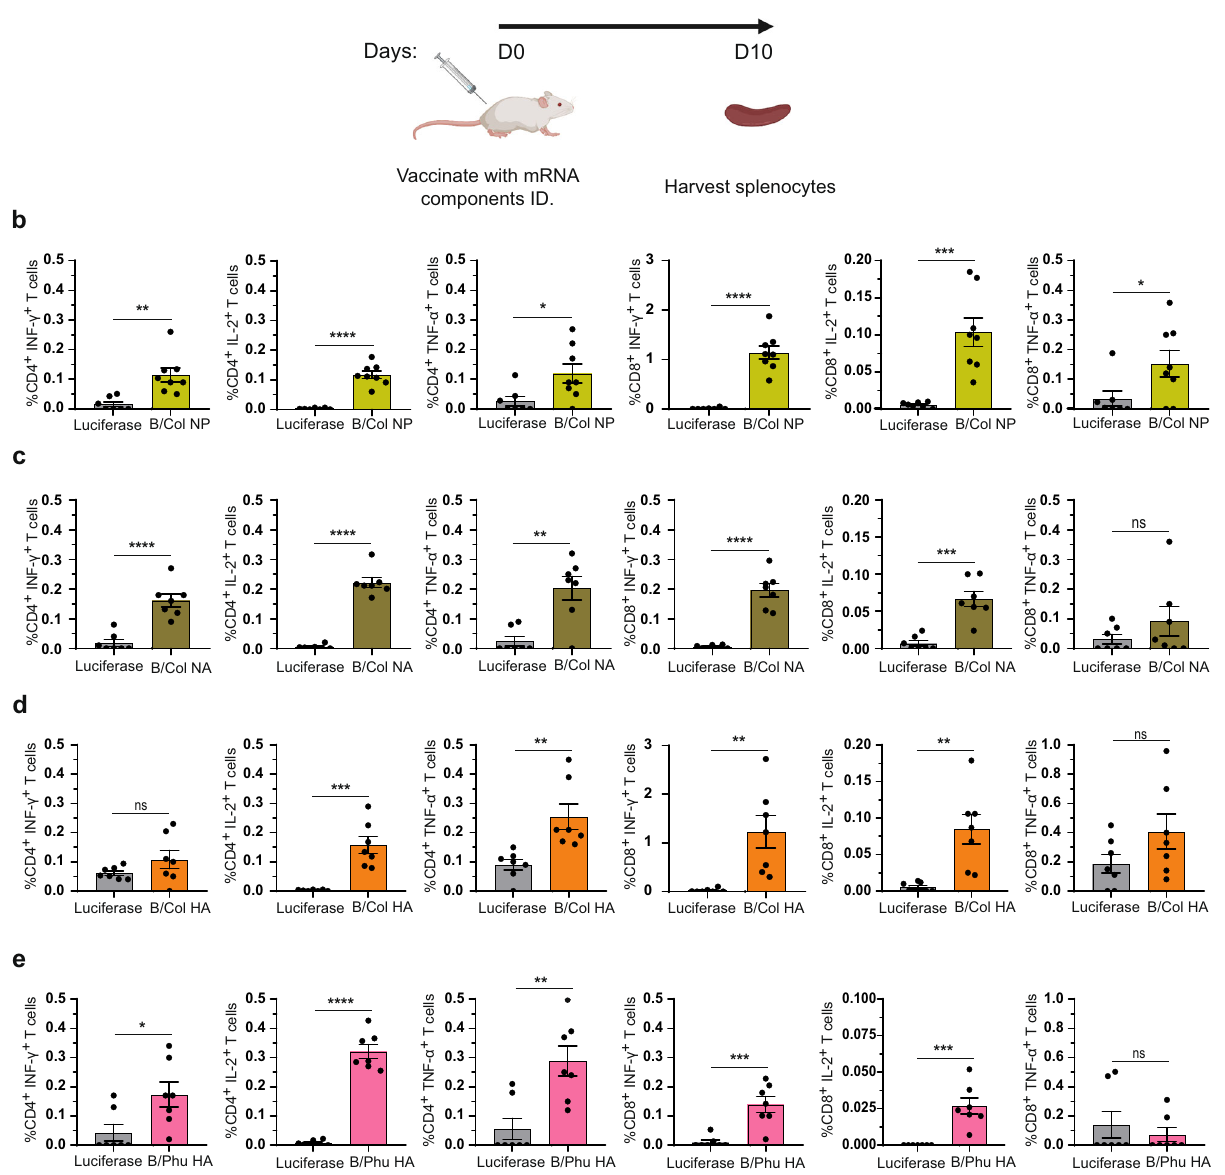
Fig. 5 | Cellular immune responses induced by IBV mRNA-LNP vaccines. Mice were vaccinated I.D. with a single dose of 5 μ g of NP, NA, HA or control luciferase mRNA-LNPs. Splenocytes collected from immunized animals 10days after immuni- zationwerestimulatedwithNPorNAorHAoverlappingpeptidepools,andcytokine production by CD4 + and CD8 + T cells was assessed by fl ow cytometry ( a ). Percen- tages of B/Col NP- ( p -values left to right 0.0023, <0.0001, 0.028, <0.0001, 0.0004, 0.0478) ( b ), B/Col NA- ( p -values left to right <0.0001, <0.0001, 0.0014, <0.0001,